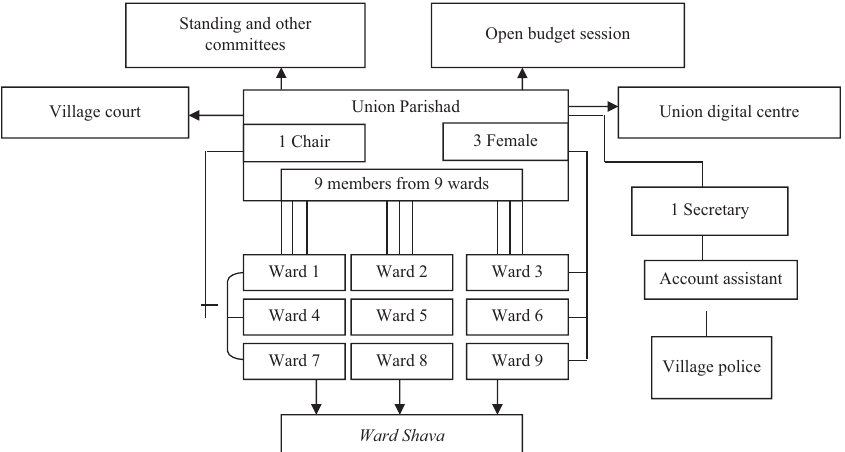
Figure 2. Organizational